Question: What visual encoding does this figure use to show its data?
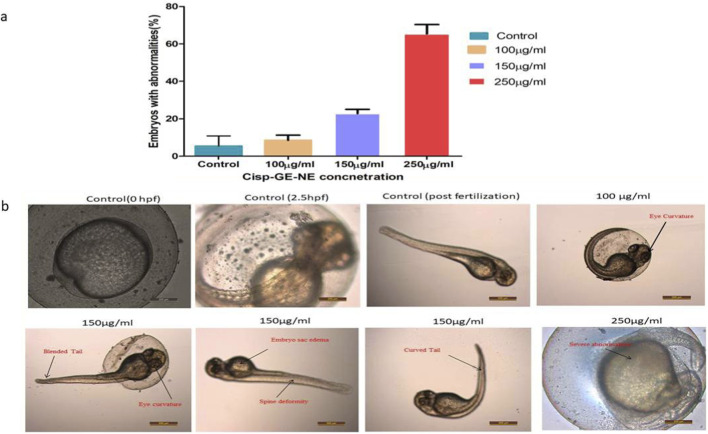
Answer: bar